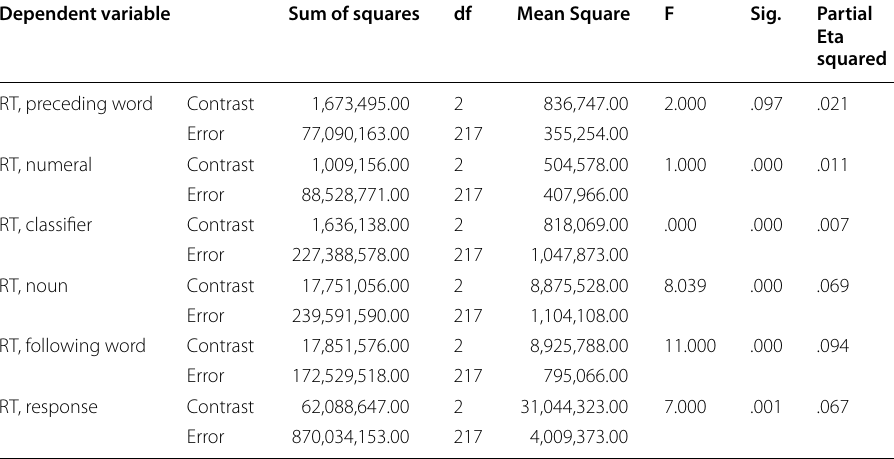
Table 3 Univariate tests (the effect of condition) Dependent variable